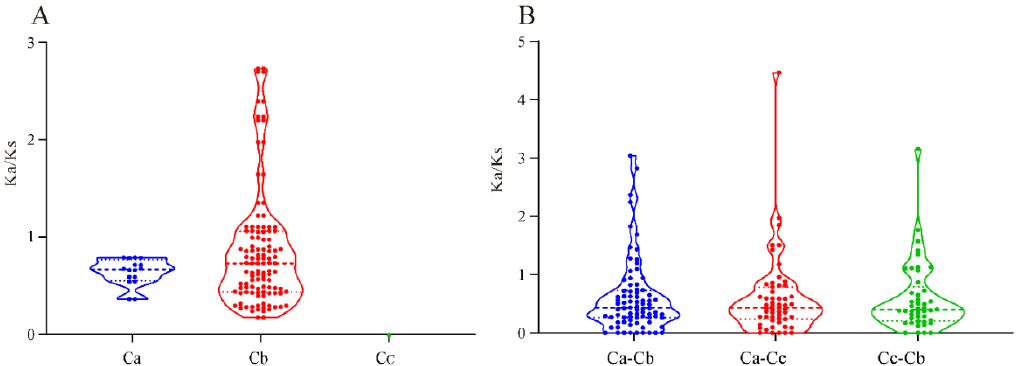
Figure 4. Selection pressure statistics of paralogous ( A ) and orthologous ( B ) MADS-box genes in pepper. Ca, C. annuum ; Cb, C. baccatum ; Cc, C. chinense. The ‘dots’ reflect the maximum and mini- mum K a/ K s scores.